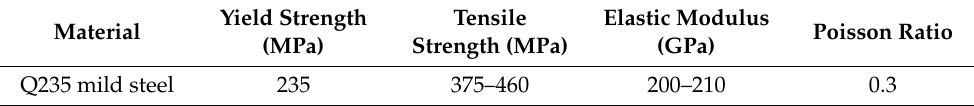
Table 1. Mechanical properties of steel plate material.